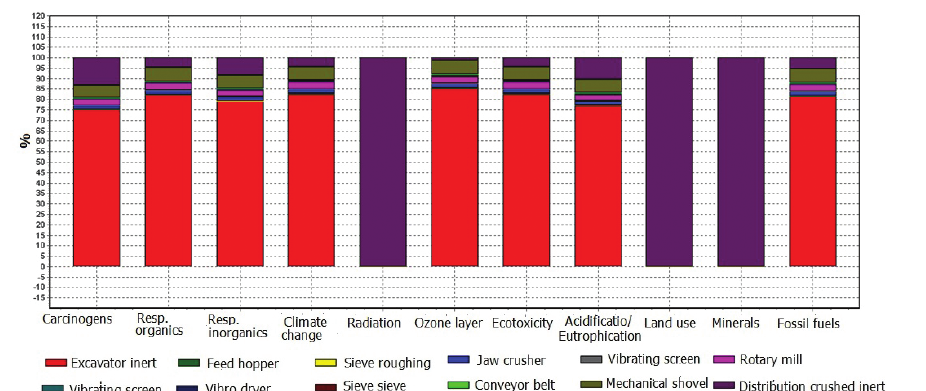
Fig. 8. Characterization of individual impacts for each phase of scenario 1 with Eco-Indicator 99